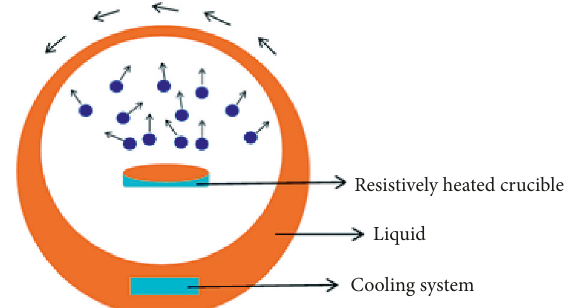
Figure 8: Schematic diagram of the nanofluid production system designed for direct evaporation/condensation of metallic vapour into low-vapour pressure liquids